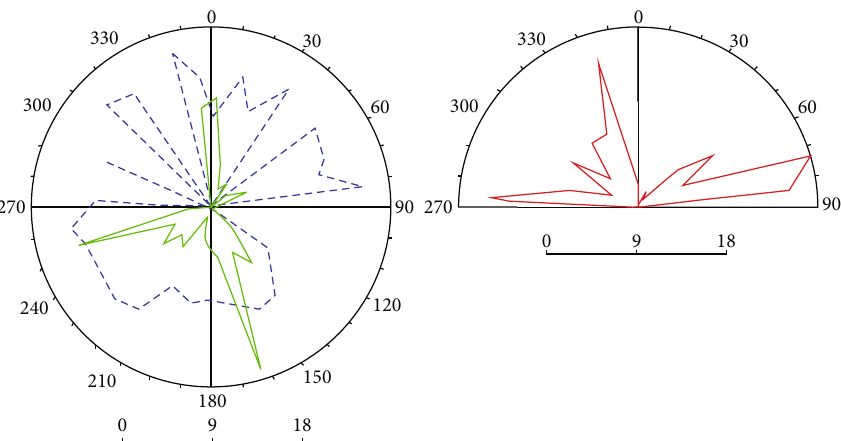
Figure 8: Longmaxi Formation ’ s overall fracture (joint) dip rose diagram, and joint azimuth rose diagram [48].